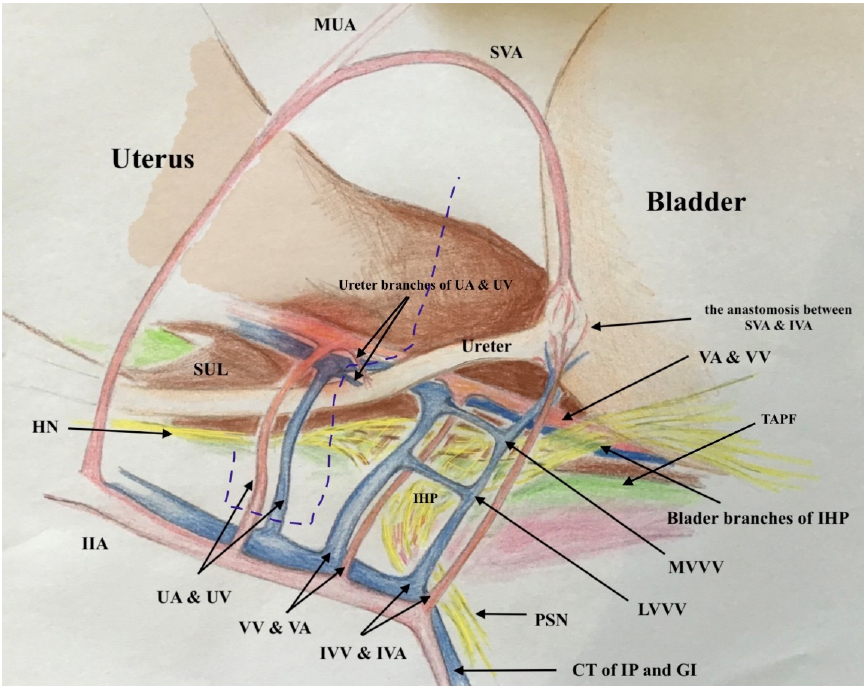
Figure 7. The graphic explanation of type II radical hysterectomy according to Muallem classifica- tion; the dotted blue line shows the resection line at the distal aspects of the ventral, lateral and dorsal parametrium. No needed resection of paracolpium. Cancers 2021 , 13 , x FOR PEER REVIEW